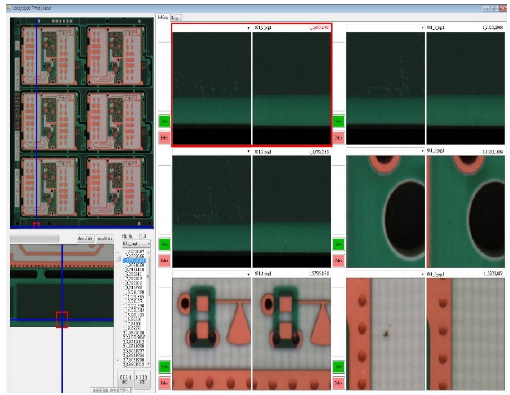
Figure 1. User interface for data collection.